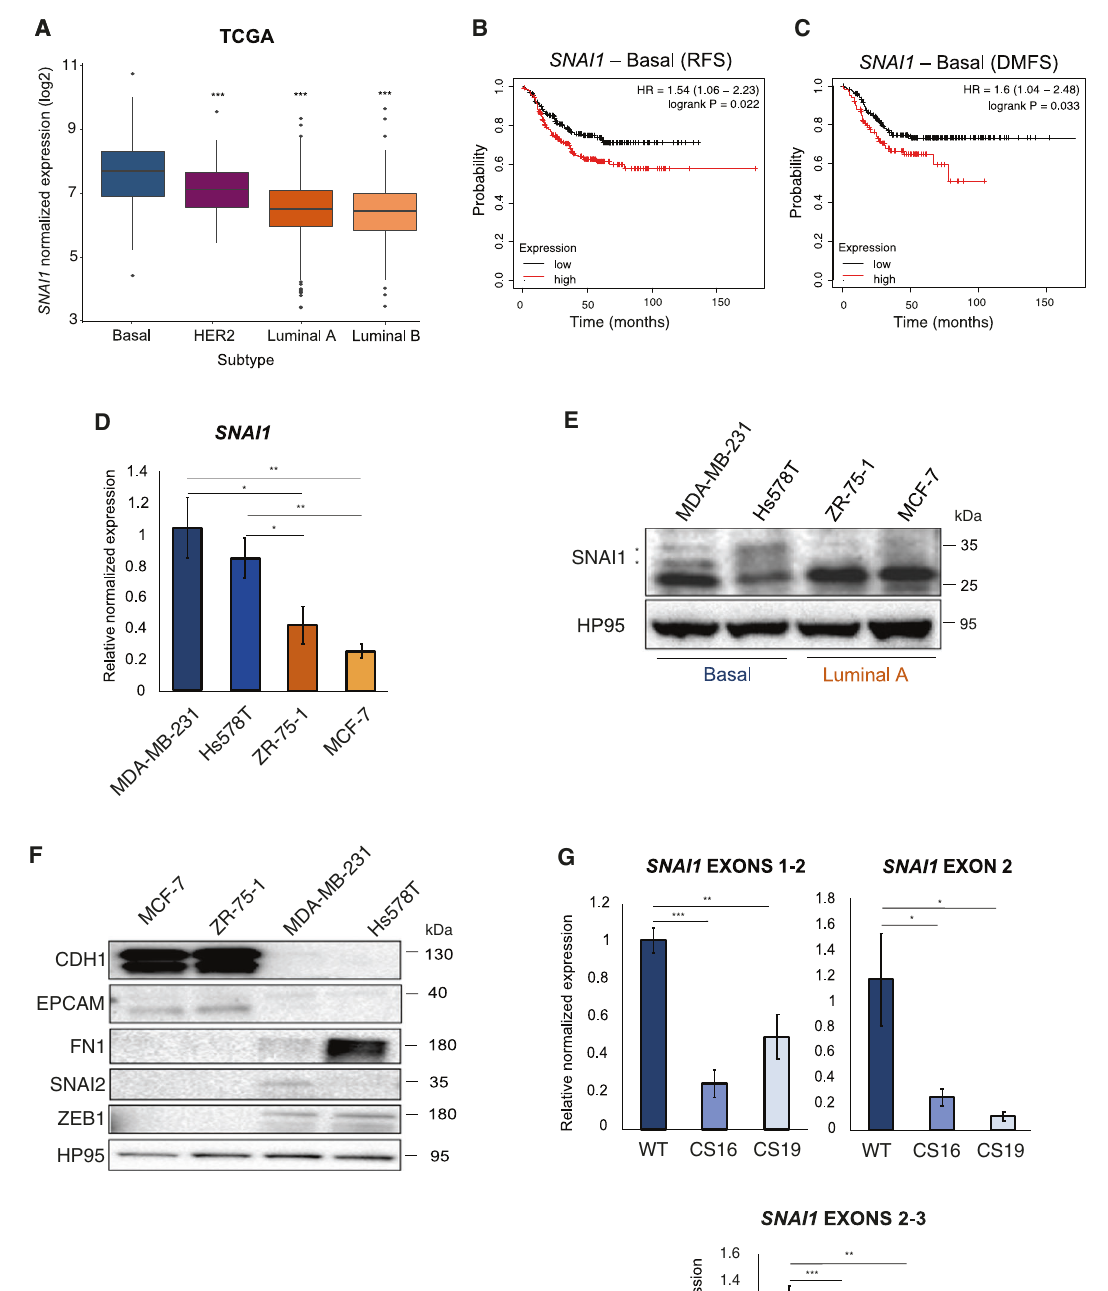
bovine serum albumin (BSA; Saveen Werner, Limhamn, Sweden) were incubated with primary antibodies and horseradish peroxidase-conjugated anti-mouse or anti-rabbit secondary antibodies (Thermo fi sher Scienti fi c) as listed in Table S7, followed by enhanced chemiluminescence assays using the Millipore kit (Merck/Millipore). The original, uncropped immunoblots are listed as the last Supplementary fi